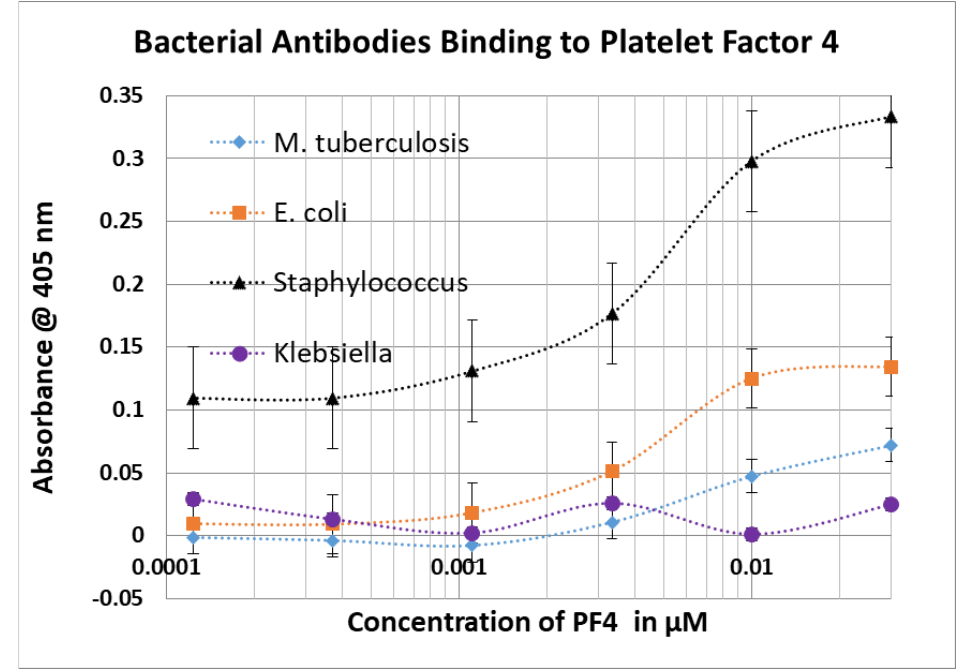
Figure 9. ELISA results showing binding of bacterial antibodies to platelet factor 4 (PF4). Experi- ments were run in duplicate.